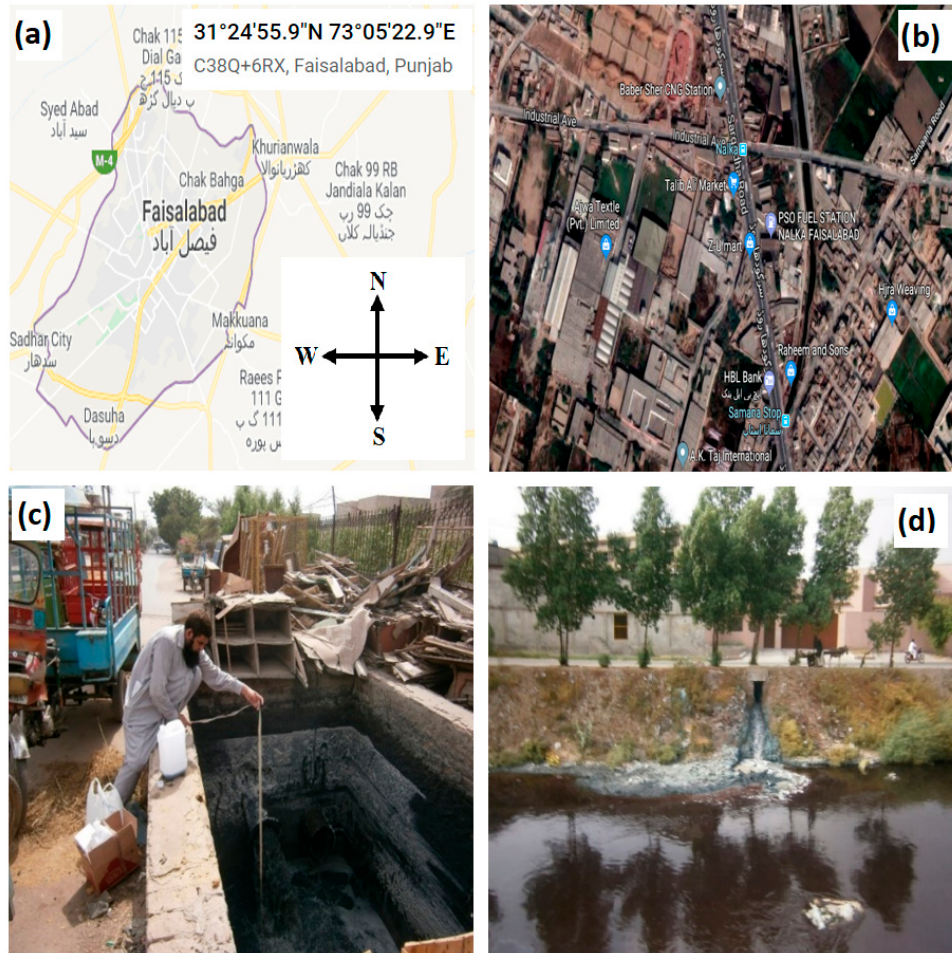
Figure 1. ( a ) Map of Faisalabad, (names of cities are translated into Urdu, the regional language), ( b ) Sample collection area taken via Google Maps, ( c ) collecting site of sample 1 and ( d ) sample 2. Table 1. Analytical techniques and instrumental details used in the study to detect different wastewa- ter contaminants and heavy